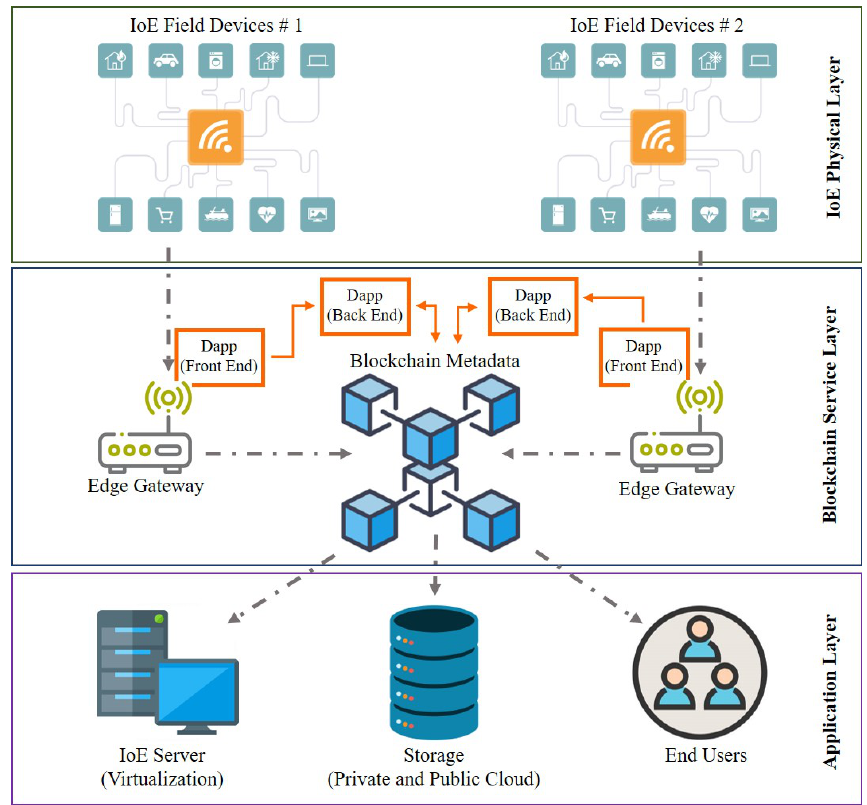
Figure 11. Proof-of-Concept Layered Architecture for IoE-Blockchain Hardware